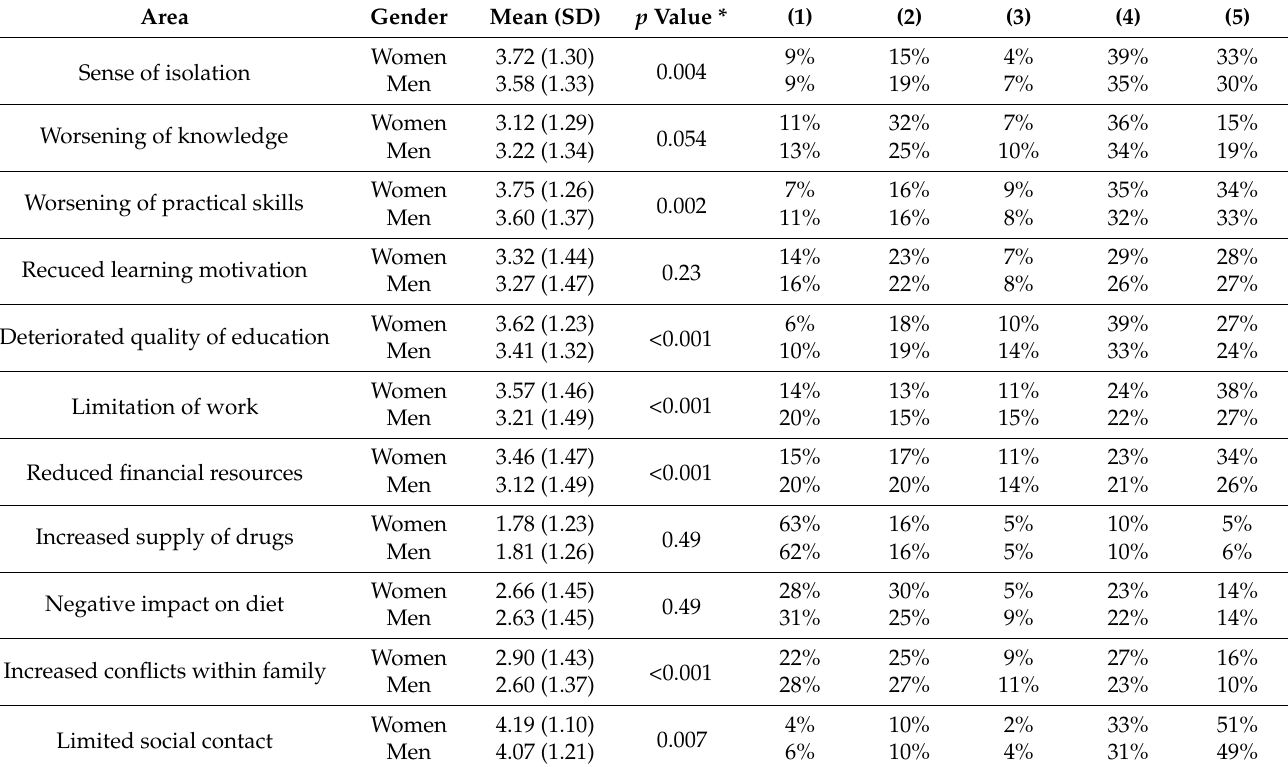
Table 4. Authors survey results with the specification of individual areas.